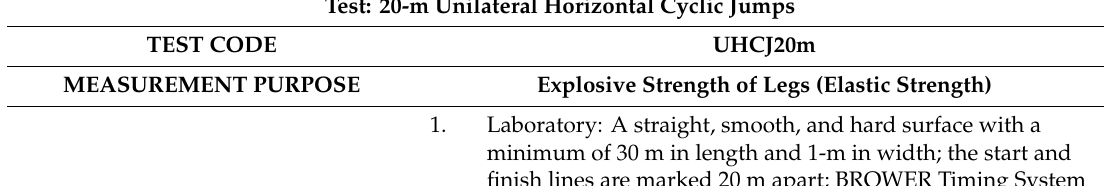
Table 1. Representation of the standardization of a motor 20 m unilateral horizontal cyclic jump test